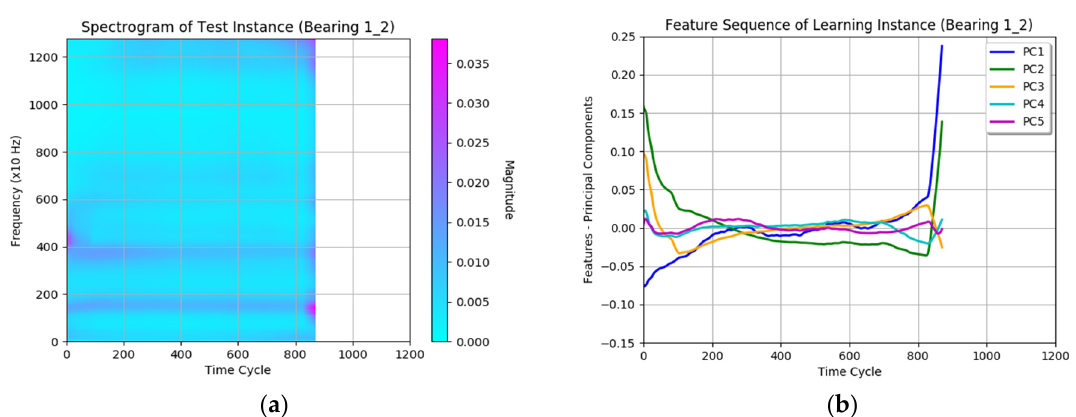
Figure 8. The spectrogram ( a ) and PC feature sequences ( b ) of learning instance Bearing1-2. Table 2. Accounts for variability of principal components of learning instances.